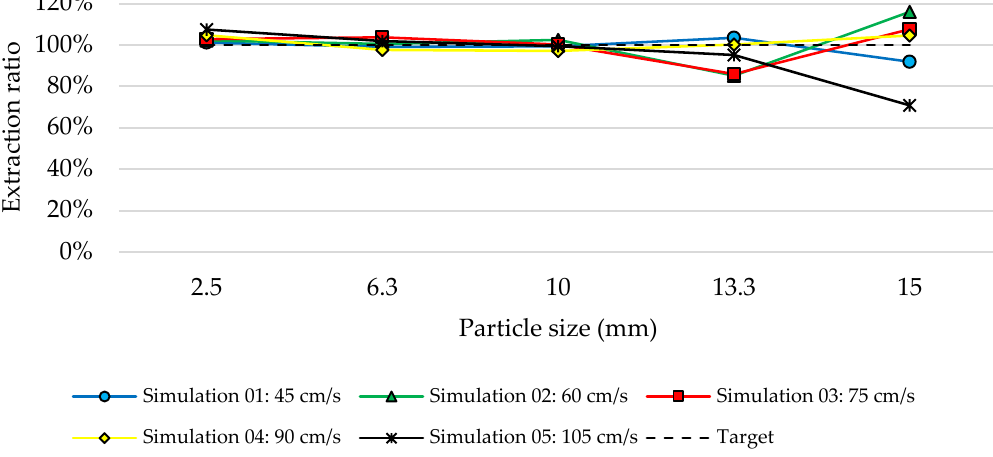
Table 8. Comparison between both grades lot x sample.